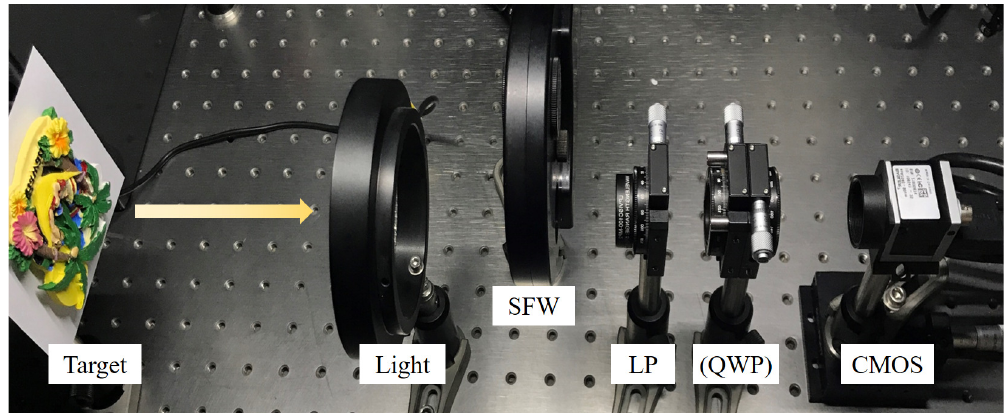
Figure 3. The definition-based polarization hyperspectral imaging (DBPHI) system.